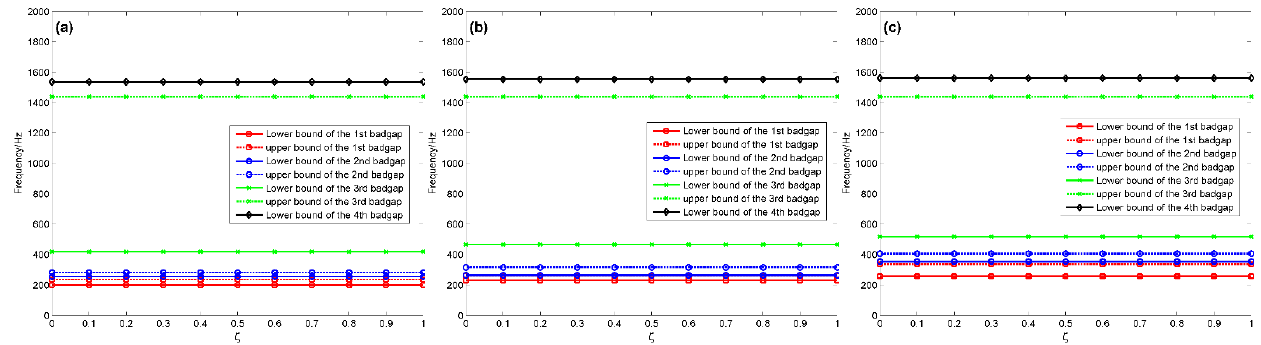
Figure 6. Lower and upper borders of the bandgaps for the infinite coupling strut: ( a ) as a function ς 0.5 η= 0.25 θ= when and ; ( b ) as a function of of ς 2 η= 0.75 θ= when and . function of